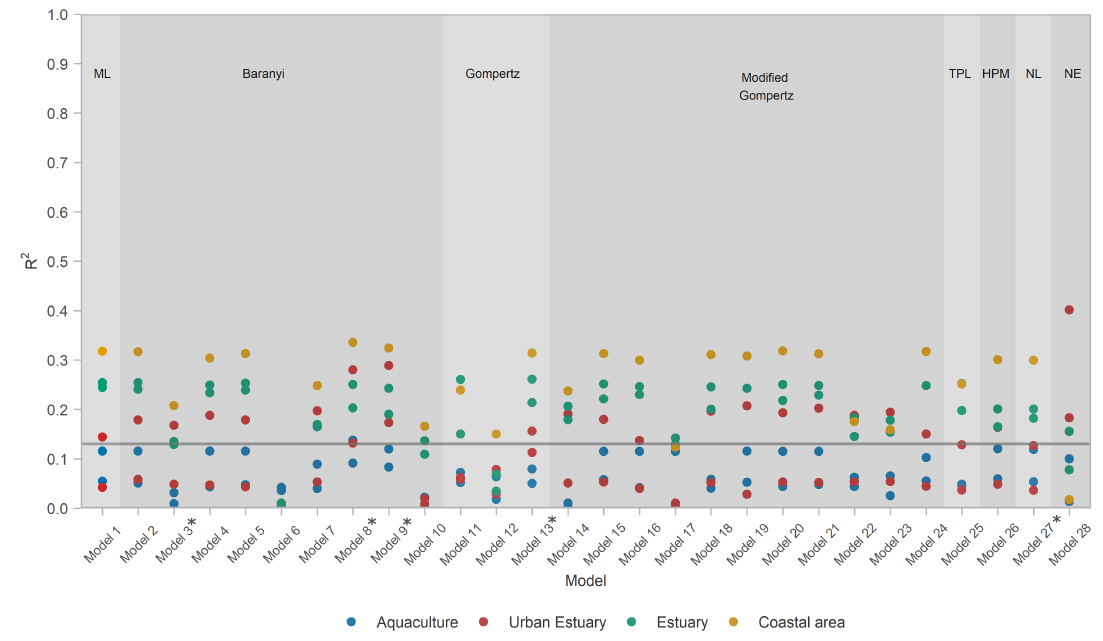
Figure 2. R 2 calculated for all models and for each dataset. Horizontal line depicts the median R 2 = 0.13 used to evaluate model performance. Primary models are labeled as follows: ML— modified logistic, Baranyi, Gompertz, modified Gompertz, TPL—three-phase linear, HPM—Huang primary, NL—no-lag and NE—net exponential. Star (*) signifies models that had an evaluation issue with some of the data points in some of the datasets (details in Appendix D).